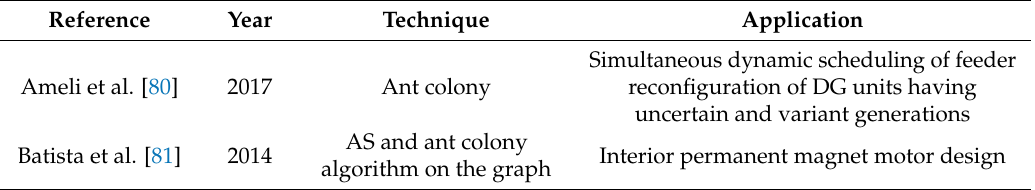
Table 6. Application of ant colony in electrical machines.